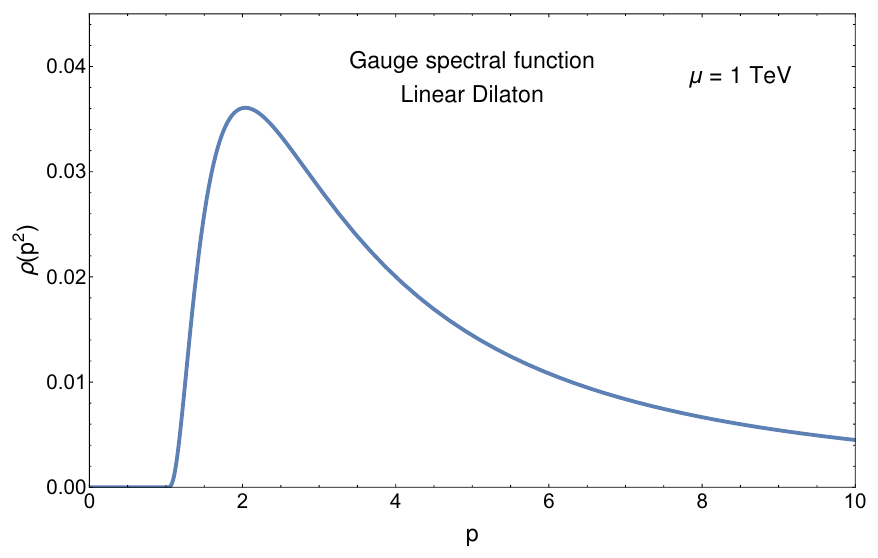
Figure 4 . The spectral density for a continuum gauge boson in a linear dilaton